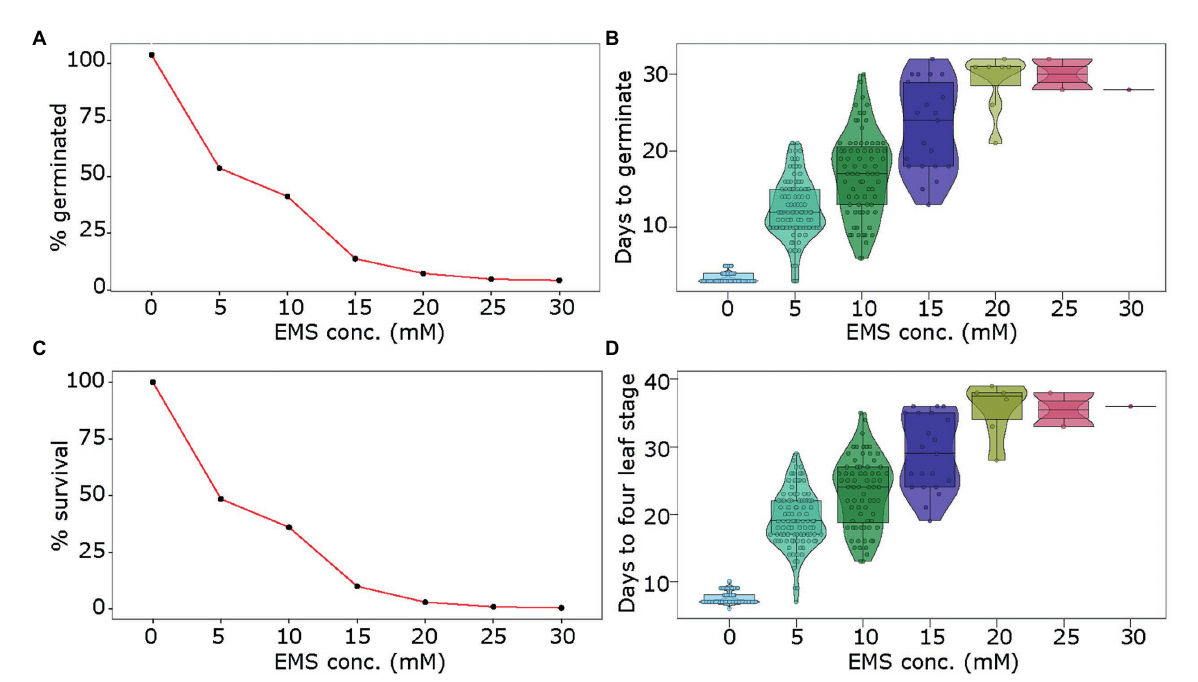
FIGURE 1 Optimization of EMS treatment for mutagenesis of pea seeds. Seeds of pea genotype CDC Amarillo were treated with different concentrations of EMS and were grown in the growth chamber. The germination rate (A) , days to germination (B) , survival rate (C) , and days to fourth-leaf stage (D) were assessed in treated and control samples to identify an optimal dose of EMS for mutagenesis of pea